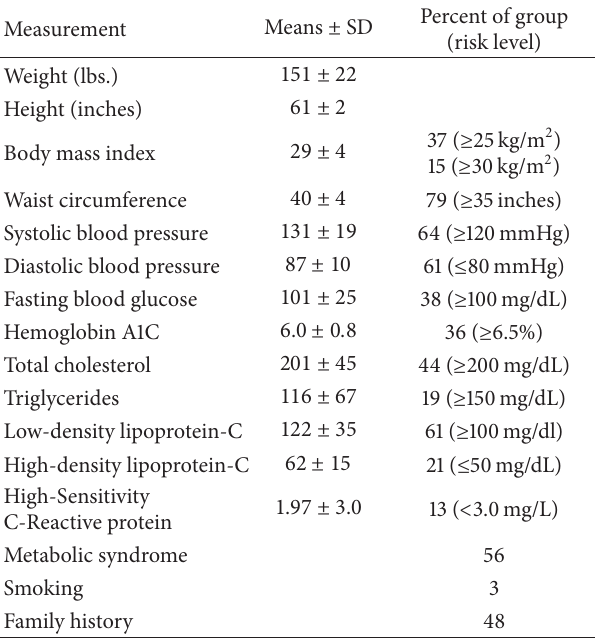
Table 2: Morphometric measurements and cardiovascular risk factors of the Filipino-American women participants ( 𝑛 = 235